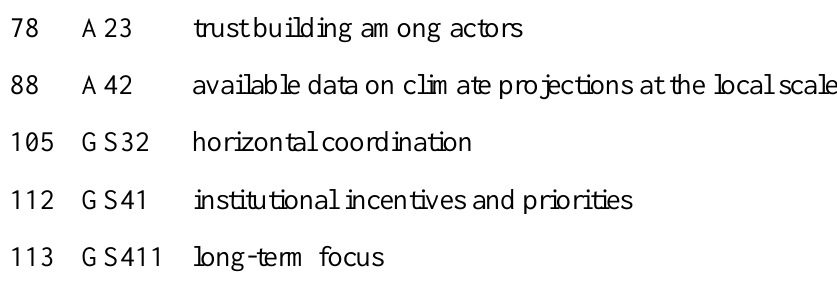
Table A1.4 Attributes of